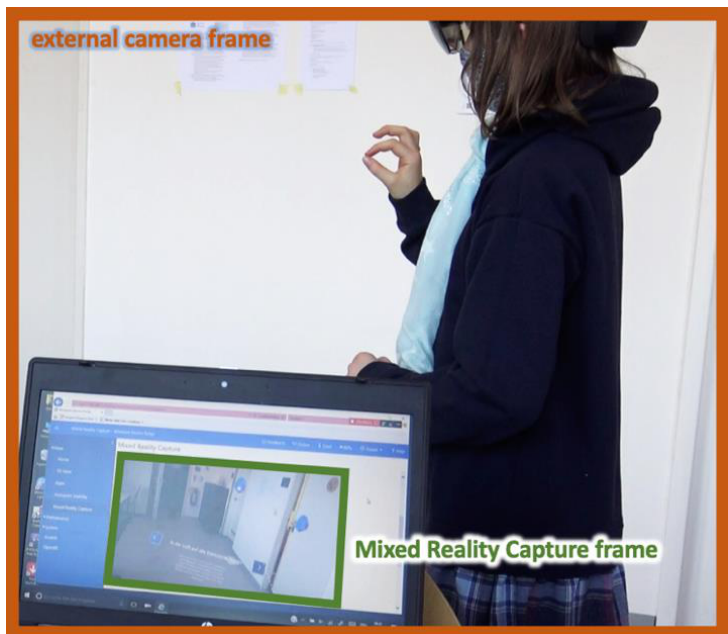
Figure 3. Video recording during the tutorial: An external camera and the ‘Mixed Reality Capture’ accessible through Microsoft Device Portal (via Browser) were used.